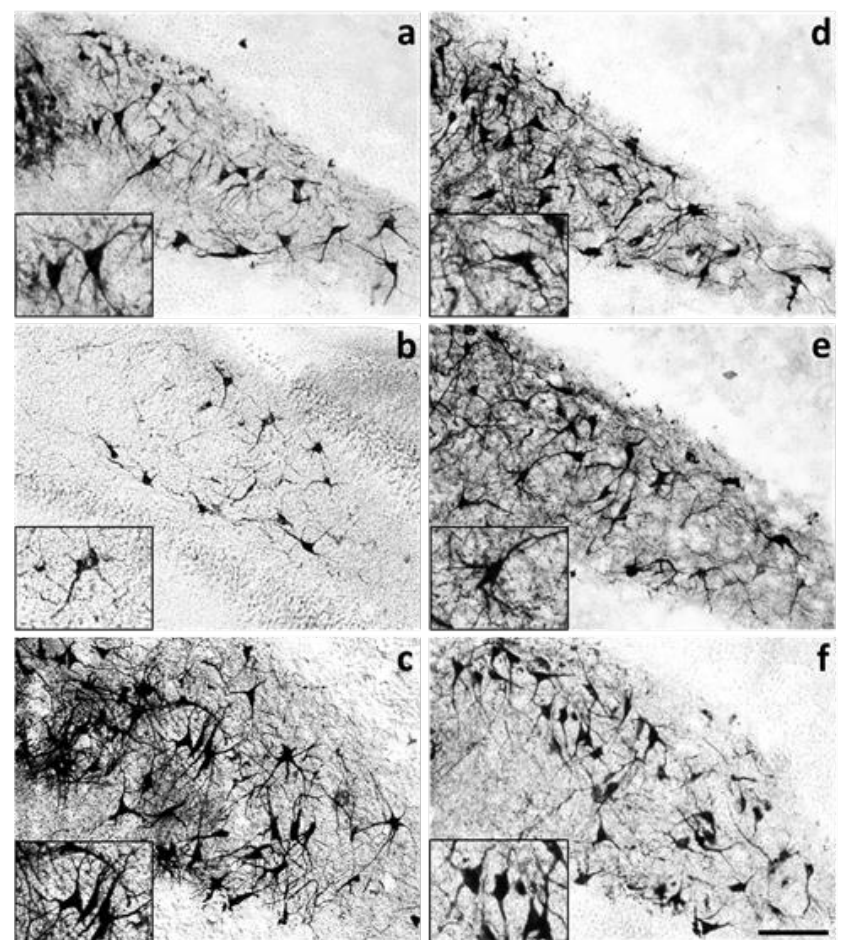
Figure 5. Melatonin neuroprotective effect on dendritic arbors damaged by okadaic acid in the hilar hippocampus. Rat hippocampal slices (400 µm) were cultured for one week and treated for 6 or 8 h. Slices were fixed as described in methods and 50 µm cryosections were processed for MAP2 detection by immunohistochemistry. Representative images of MAP-immunostained treated slices are shown as follows: ( a ) vehicle (VEH); ( b ) 45 nM okadaic acid (OKA); ( c ) 100 nM melatonin (MEL); ( d ) MEL before OKA; ( e ) simultaneous MEL and OKA; ( f ) OKA before MEL. Inserts highlight the dendritic arbors of hilar neurons. Scale bar in ( f ): 100 µ